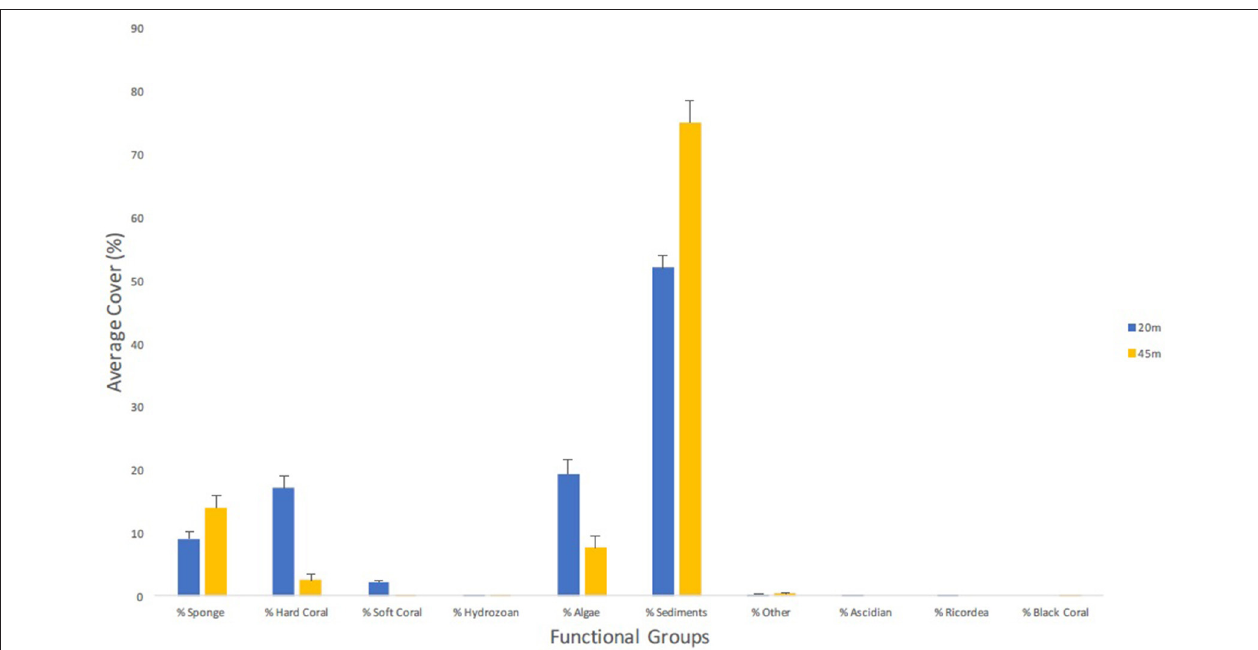
FIGURE 7 | Average percent cover ( + SE) of major functional groups from both the altiphotic and deep transect surveys along the central portion of the Guánica shelf edge. A total of 40 m 2 were surveyed per depth stratification and percent cover was calculated in CPCe and tabulated using custom Linux